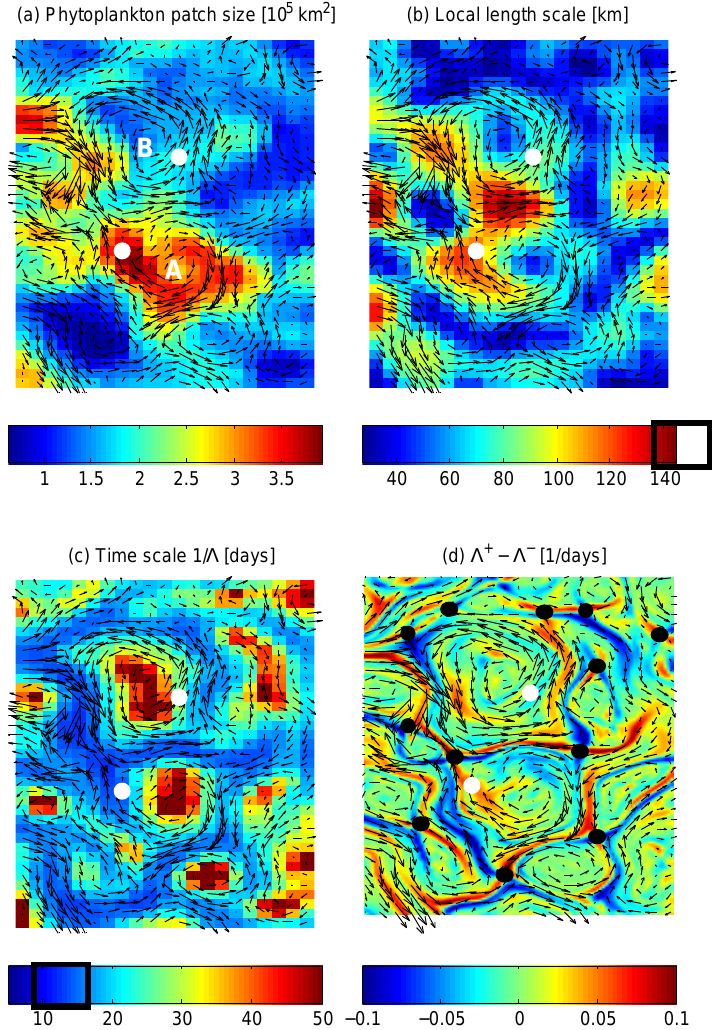
Fig. 9. Discrepancy in plankton growth in two apparently similar eddies: Size of plankton patch for a selected region in the North Atlantic Ocean after 30 days of simulation (a) . For each grid point, colour indicates the patch size B s × 10 − 5 km 2 after a nutrient upwelling took place at that location. Red/blue colour shows areas with larger/smaller phytoplankton patch. In eddy A, plankton growth is favoured. The representations of Eulerian length scales and Lagrangian time of the flow (b, c) show that both long length scales ( λ > 120km) and short time scales ( τ L < 15days) are necessary for a large plankton patch size. Black boxes at the colour bars show the optimal time and length scales found for the Gaussian correlated flow. Finite-Time Lyapunov Exponents (d) for the same region and period of time as for panels (a, b, c) calculated forward (displayed as positive values) and backward (displayed as negative values) integrations in time. The plotted field is 3 + −| 3 − | (see Appendix A). Mesoscale structures with jets and vortices can clearly be observed. The black dots indicate the hyperbolic points that are located at the intersections of the stable (red) and unstable (blue) manifolds. Eddy A is surrounded by 5 hyperbolic points with the same distance. They act as exits to other favourable regions. The hyperbolic points surrounding eddy B have smaller and less uniform distances. White dots correspond to the positions of the exemplary nutrient sources in Fig.